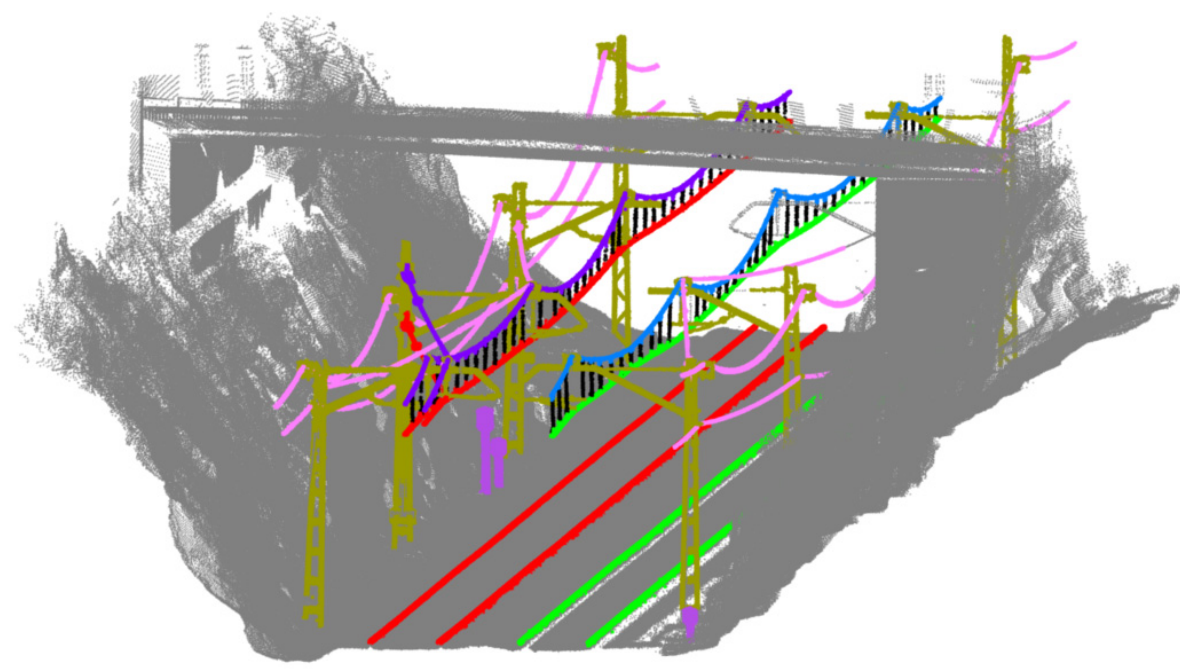
Figure A2. Railway under an overpass: masts are represented in gold colour. Each contact wire has a different colour (green and red), matched by its correspondent rail. Each catenary has also a random colour. Other wires are coloured in pink, droppers in black, and marks in magenta.